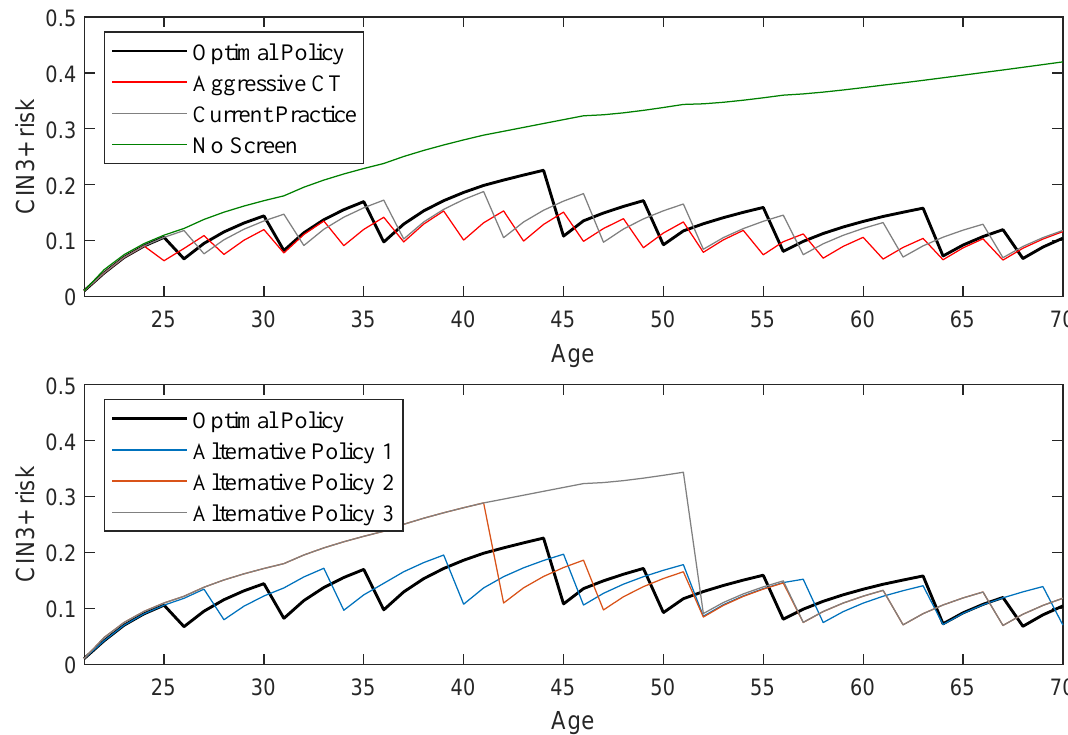
Figure 6. Lifetime risk of cancer under different policies.